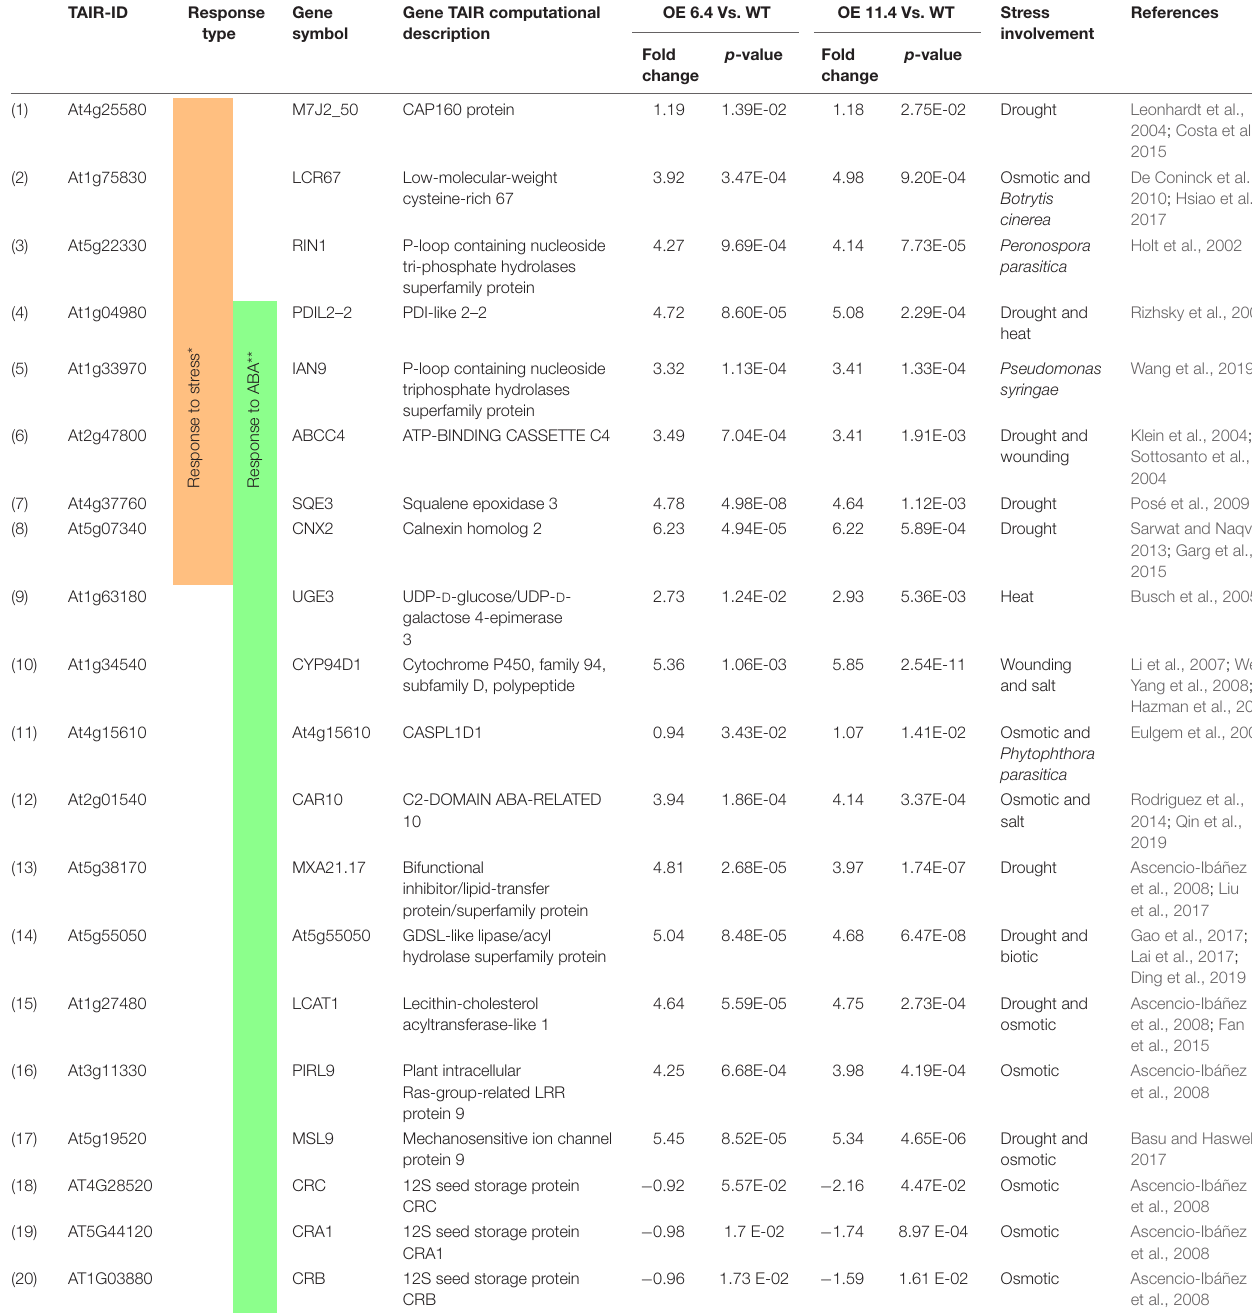
TABLE 1 | Differentially expressed stress related genes identified through PM-proteomics of RabA2b over expressing plants. TAIR-ID Response